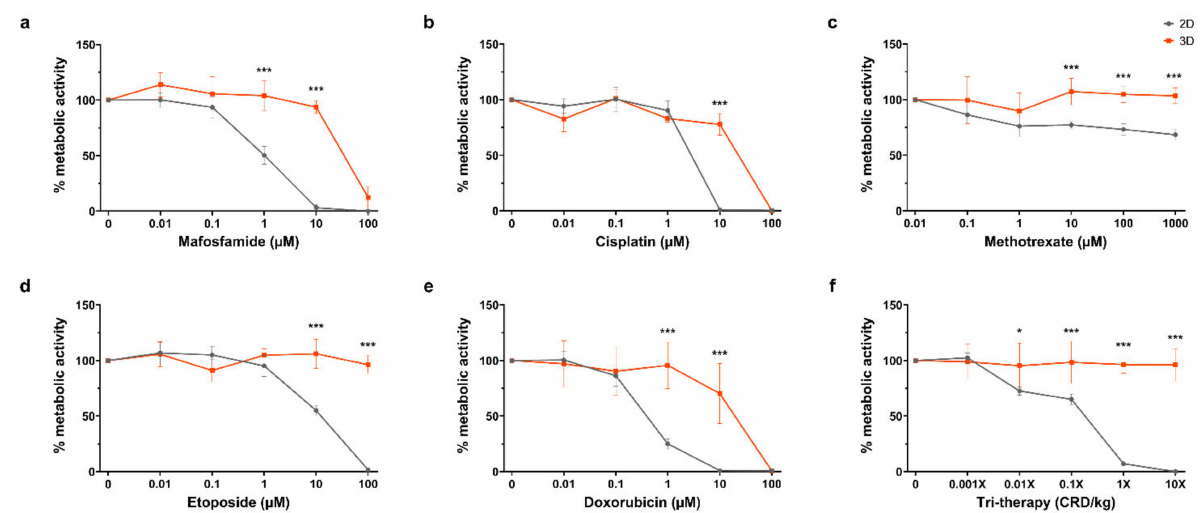
Figure 4. Drug response on 2D vs. 3D after 4 days. ( a – f ) Alamar blue assay after treatment with scalar doses of mafosfamide, cisplatin, methotrexate, etoposide, doxorubicin, and tri-therapy cocktail. Represented as % metabolic activity relative to untreated control D4/D1. Data is expressed as Mean ± SD of n = 4 samples. p -values; * p ≤ 0.05, *** p ≤